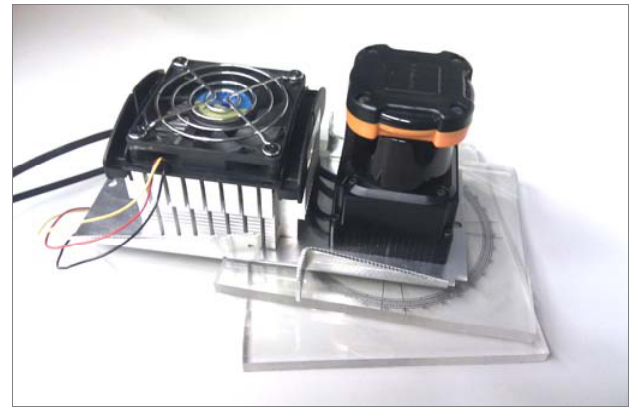
Figure 2. Laser sensor and additional cooler on a rotating structure.